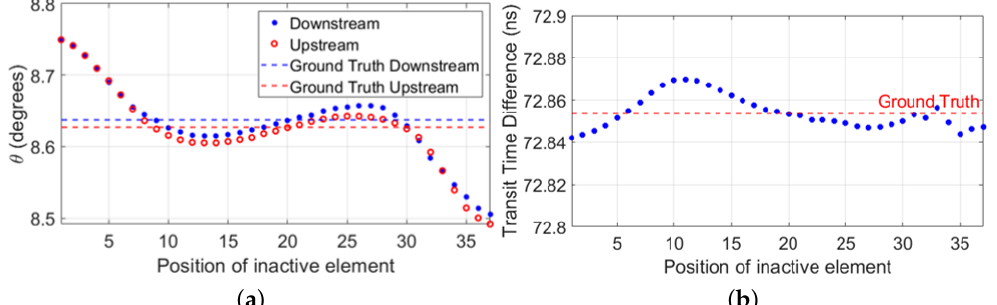
Figure 2. Simulation results obtained using FIELD II [28,29] to generate acoustic beams in wa- ter steered at an angle of θ = 8.6 ◦ relative to the normal of the surface of a 37-element trans- ducer array. The flow effect was included by defining the sound speed of the medium as c = 1480m/s ∓ v f cos ( 8.6 ◦ ) , with v f = 0.5m/s being the flow speed, and where ∓ defined the acous- tic wave propagating upstream and downstream, respectively. The beams were measured in the far field. ( a ) Location, relative to the surface of the transducer array, of the peak amplitude of each ill- generated beam as a function of the position at which the inactive element is located on the array. The dashed horizontal lines show the ground truth locations, i.e., those obtained with fully working arrays. ( b ) Transit time difference offset introduced by the distorted travel paths described by the ill-defined beams. The dashed horizontal line indicates the ground truth transit time difference, i.e., the one obtained with fully working arrays.